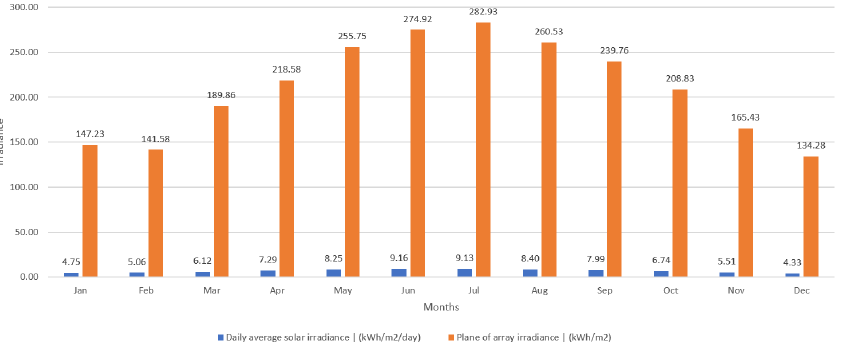
Figure 14. Graph of monthly average solar irradiance and array irradiance in khW/m 2 for Hickman, KY [27].